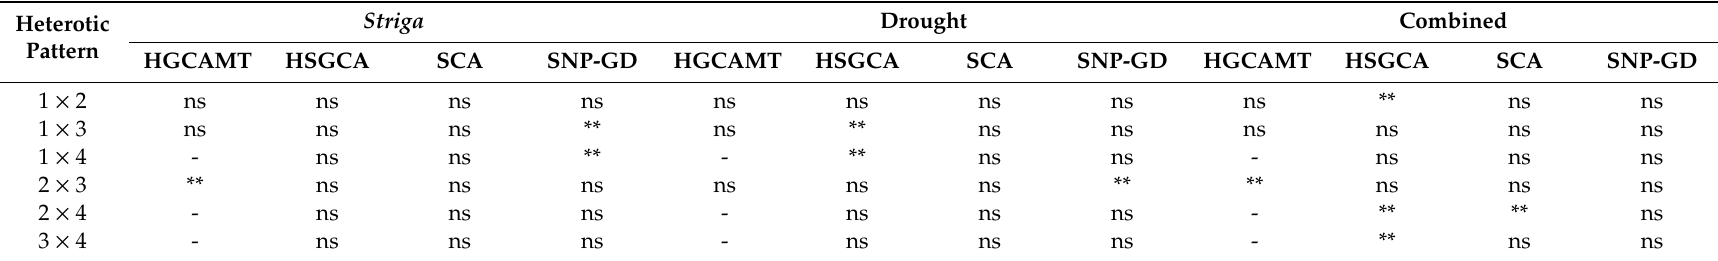
Table 8. Heterotic patterns obtained from heterotic groups defined by HGCAMT, HSGCA, SCA, and SNP-GD grouping methods. Heterotic Pattern